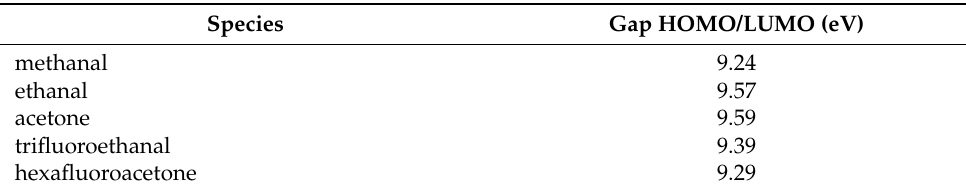
Table 3. Comparison of the HOMO/LUMO gaps for the solvated oxo-species. Species Gap HOMO/LUMO (eV)